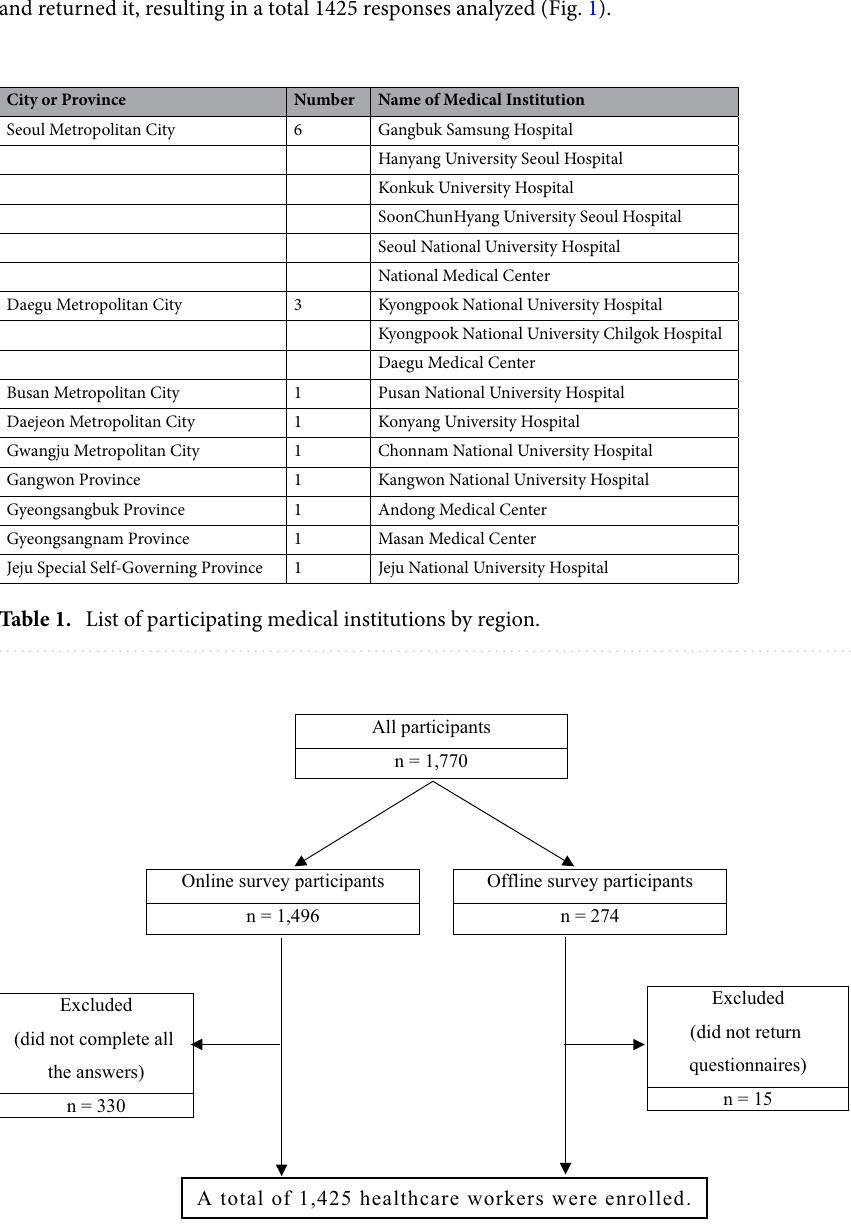
Figure 1. Flow chart describes the study enrollment